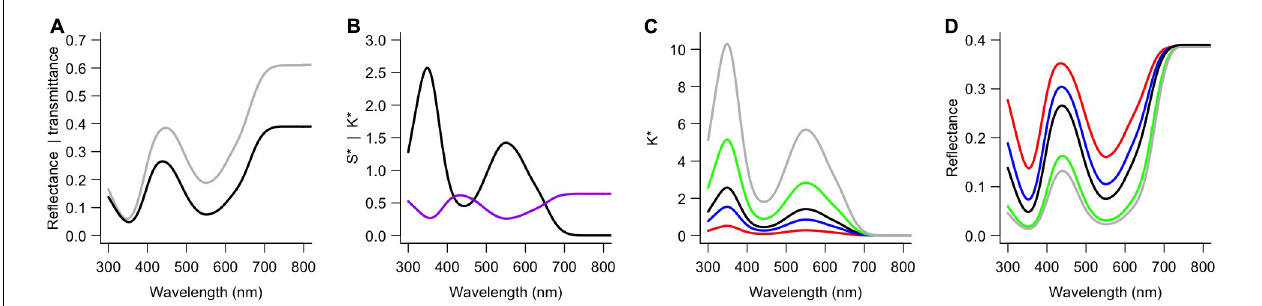
FIGURE 3 | Example spectra and calculations for the blue flowers of Nolana paradoxa . (A) Measured reflectance (black) and transmittance (gray) spectra (as in Figure 2B ). (B) Absorption ( K *, black) and scattering parameter ( S *, purple) calculated using the measured spectra from panel (A) . (C) Different absorption parameters used for the modeling; 0.2 K * (red), 0.6 K * (blue), K * [black, as in panel (B) ], 2 K * (green) and 4 K * (gray). (D) Reflectance spectra obtained using the absorption parameters as in panel (C) (with corresponding